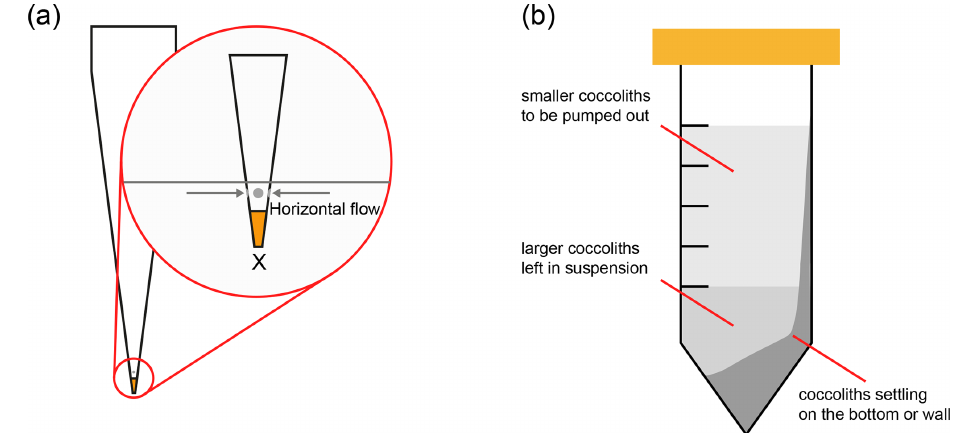
Figure 4. Two methods to reduce the coccolith size overlapping. (a) Adaption of pipette tip: the orange part on the tip is sealed by solidified glue, and the gray parts mean that small holes should be drilled allowing the suspension to flow in horizontally; (b) choose a proper pumping position to avoid extracting the coccolith on the tube wall. The lightest gray part in the tube represents the suspension in which the smaller coccolith floats; most of the larger coccoliths are in the lower part of the suspension and the tube